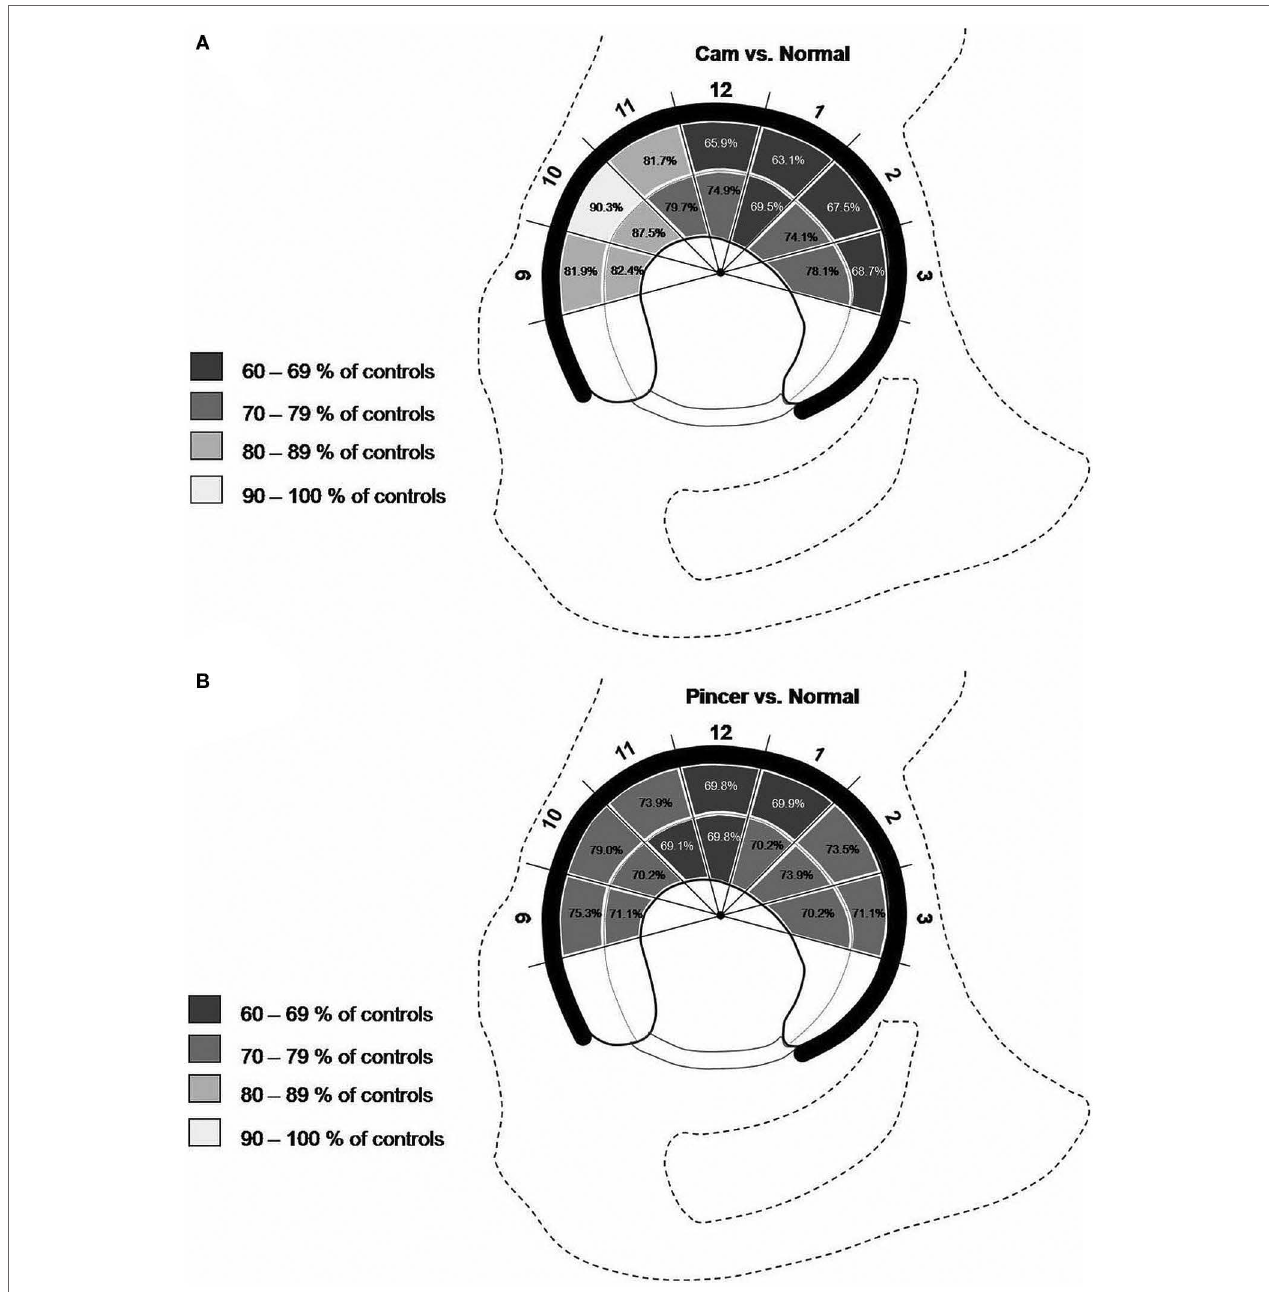
aspect of the joint, the cam-FAI group exhibited not only a peripheral but also a central cartilage T1 Gd decrease (A) , whereas the pincer-FAI cohort demonstrated a rather global T1 Gd decrease for all areas of the hip (B) . Figure reprinted with permission